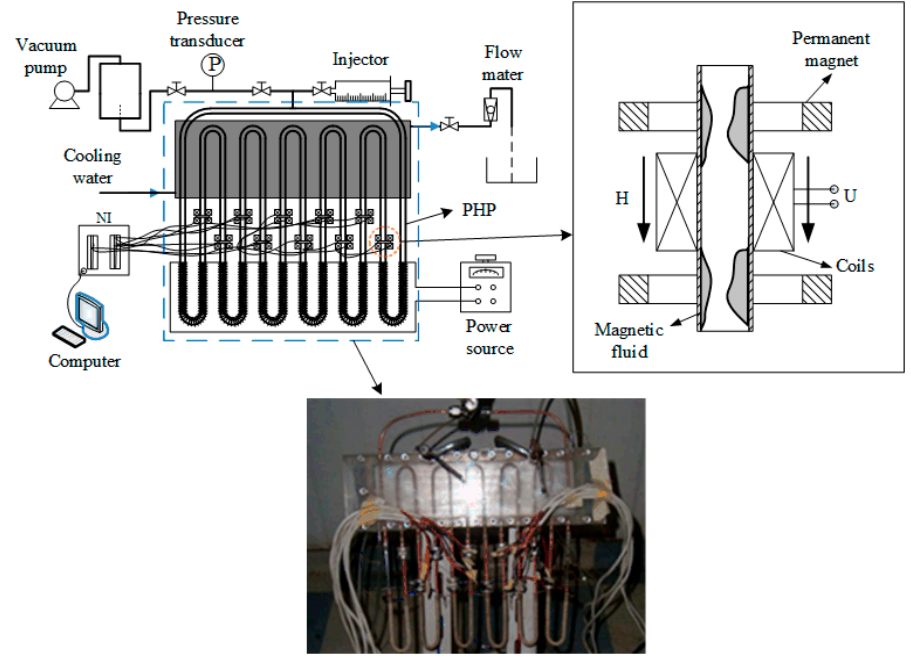
Figure 5. Schematic of the whole experimental system.